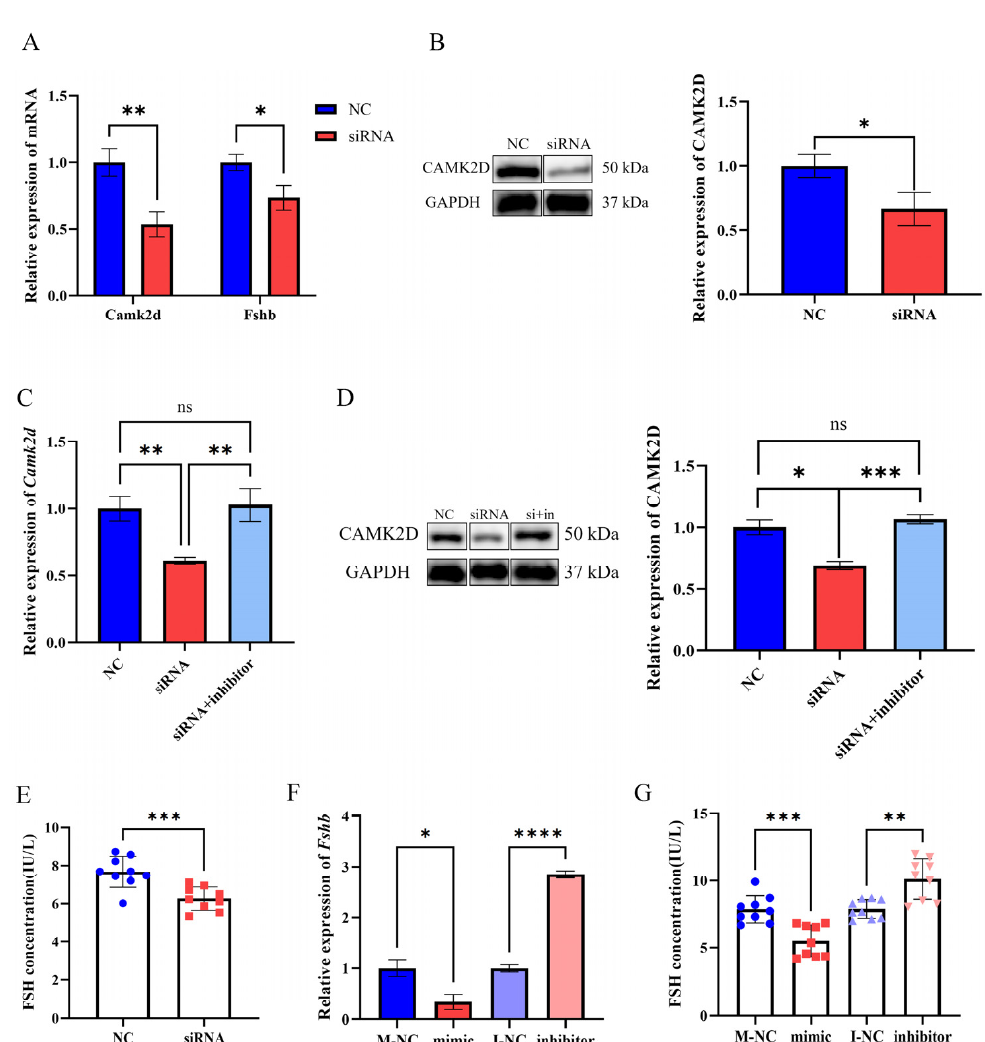
Figure 9. LncRNA-m23b is involved in the regulation of the FSH synthesis and secretion by targeting Camk2d expression through competitive binding with miR-23b-3p. ( A ) mRNA changes after lncRNA-m23b knockdown. ( B ) The CAMK2D protein changes after lncRNA-m23b knockdown. ( C , D ) Camk2d mRNA and CAMK2D protein changes after co-transfection of siRNA-lncRNA-m23b-2 with miR-23b-3p inhibitor. ( E ) FSH secretion changes after lncRNA-m23b knockdown. ( F , G ) Fshb mRNA and FSH secretion changes after miR-23b-3p mimic/inhibitor transfection. ns, p > 0.05; *, p < 0.05; **, p < 0.01; ***, p < 0.001; ****, p <